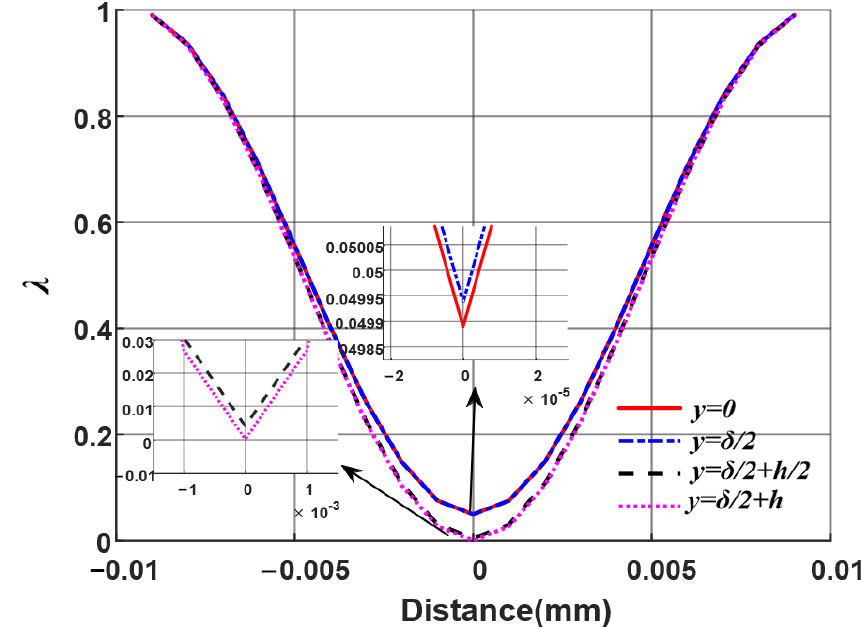
Figure 9. Air-gap relative permeance at different positions in a single slot.